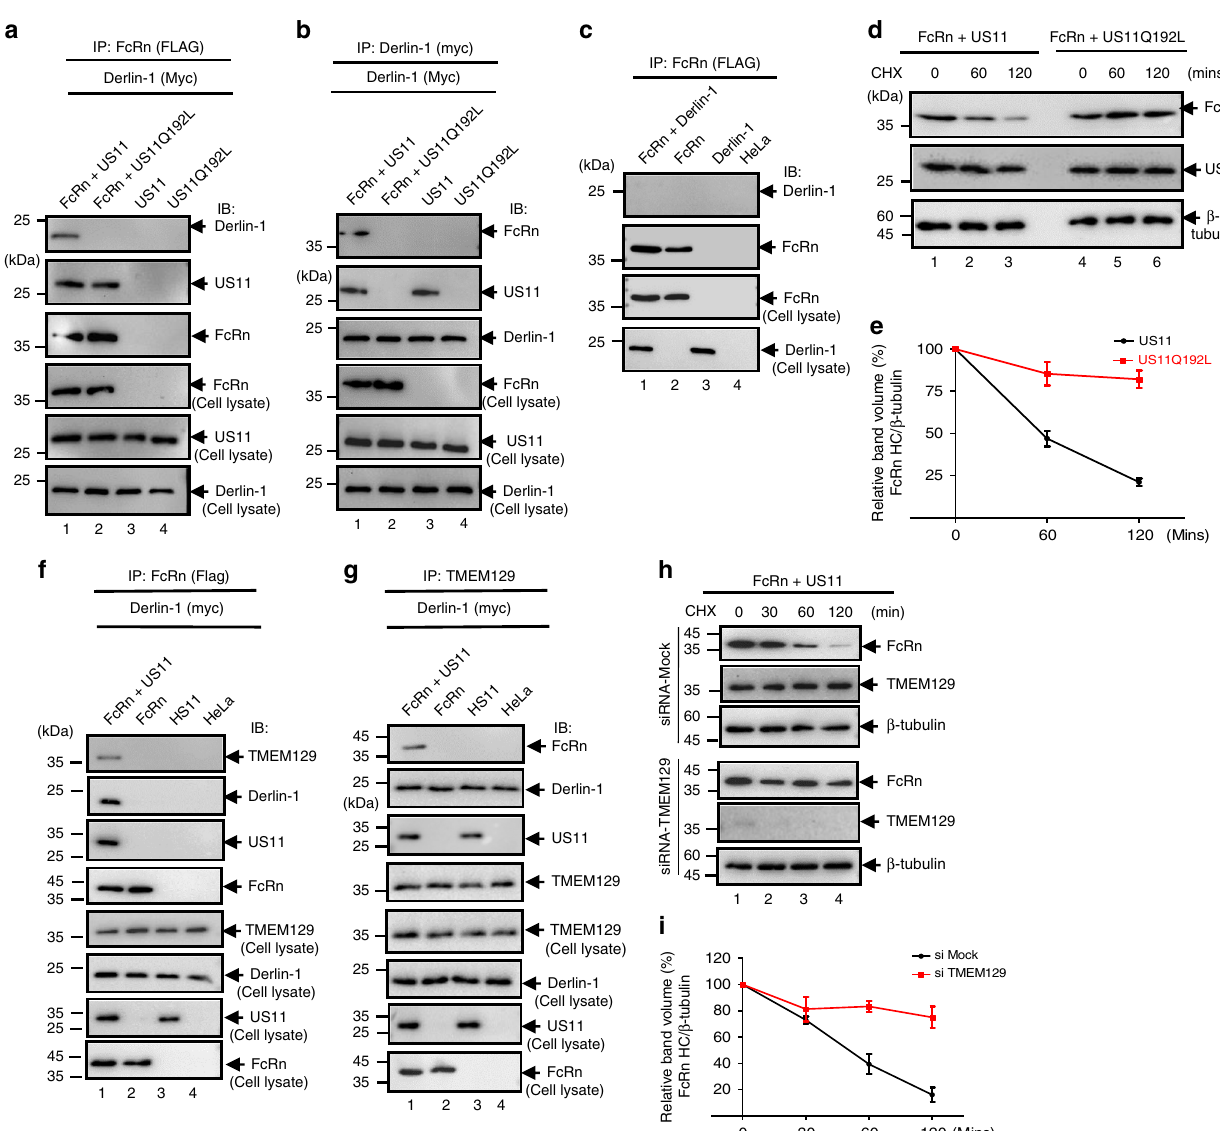
Fig. 4 US11 recruits FcRn to Derlin-1 and TMEM129 protein complex. a – c US11 recruits FcRn to the Derlin-1 complex. US11Q192L represents a mutant US11 in which Q192 is replaced with leucine. Stable HeLa FcRn , HeLa FcRn + US11 , HeLa FcRn + US11Q192L , HeLa US11 , and HeLa US11Q192L cell lines were transfected with a plasmid encoding myc-tagged Derlin-1. Forty-eight hours after transfection, the cell lysates (0.5 mg) were immunoprecipitated with mAb anti-FLAG for FcRn ( a , c ) or anti-myc for Derlin-1 ( b ). Non-transfected HeLa FcRn or HeLa cells were used as a negative control. d , e FcRn in mutant US11 Q192L transfected cells resists degradation. HeLa FcRn + US11 and HeLa FcRn + US11* cells were treated with CHX (100 μ g/ml) for the indicated time ( d ). Cells were lysed after CHX treatment and cell lysates (20 μ g) were subject to western blotting with corresponding Abs as indicated. The level of remaining FcRn ( e ) at different time points was quanti fi ed as the percentage of the β -tubulin level. f , g US11 recruits FcRn to TMEM129 complex. HeLa FcRn + US11 (lane 1), HeLa FcRn (lane 2), HeLa US11 (lane 3), and HeLa cells were transfected with Derlin-1 plasmid. Forty-eight hours later, the cell lysates were immunoprecipitated by mAb anti- FLAG for FcRn ( f ) or anti-TMEM129 Ab ( g ). h , i TMEM129 is involved in US11-mediated FcRn degradation. The HeLa FcRn + US11 cells were transfected with 20 nM TMEM129 siRNA oligomers ( h , bottom). Forty-eight hours later, cells were then treated with CHX (100 μ g/ml) for the indicated time. The cells were lysed after CHX treatment and cell lysates (20 μ g) were subjected to western blotting with Abs as indicated. The level of remaining FcRn ( i ) in TMEM129 siRNA-treated cells (red) or mock-treated cells (black) at different time points was quanti fi ed as the percentage of the β -tubulin level. All immunoprecipitates or cell lysates (20 μ g) as controls were subject to western blotting with corresponding Abs as indicated ( a , b , c , f , and g ). The percentage of time point 0 (min) is assigned a value of 100% and the values from other time points are normalized to this value ( e , i ). Error bars: mean ± SEM of three independent